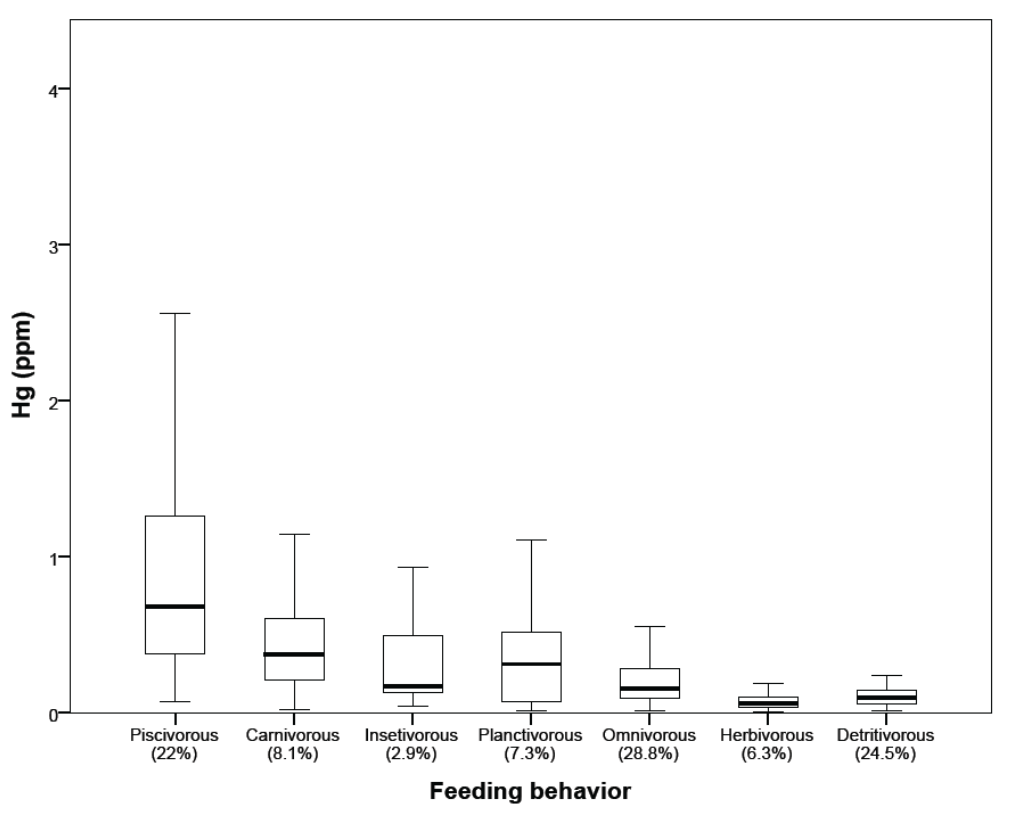
Figure 4. Box-plot representation of total-Hg concentrations in fish-muscle of 110 species caught at the 15 sampling sites as a function of fish feeding